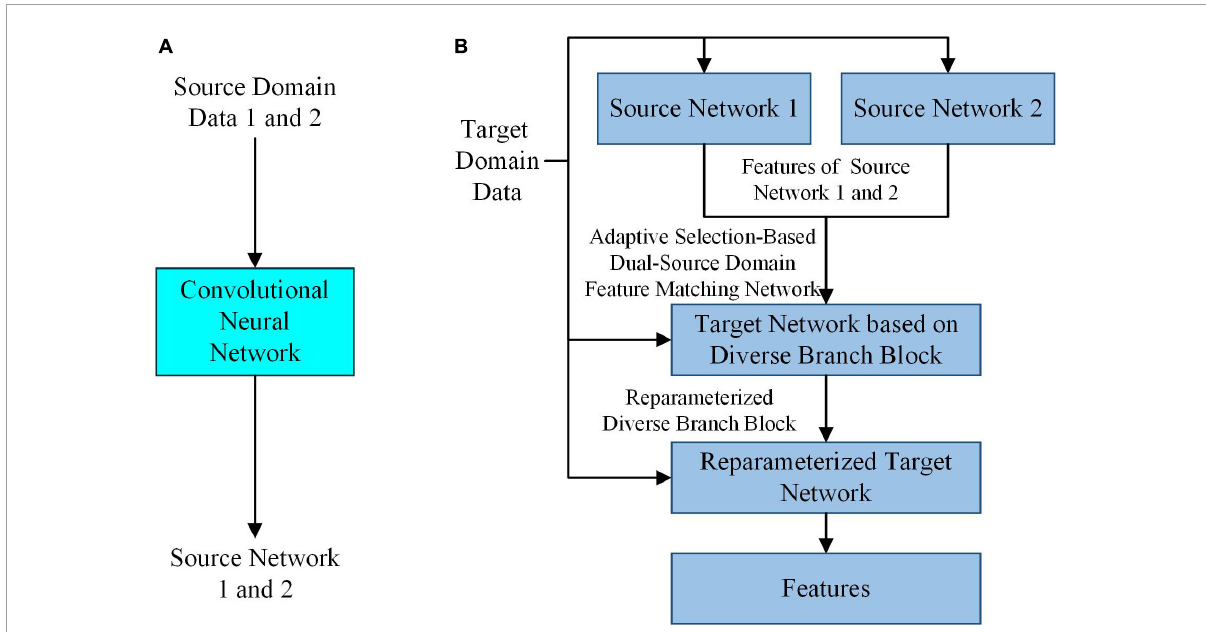
FIGURE2 The overall architecture of the feature extraction model. (A) Training of the source network. (B) Training of the target network based on diverse branch block and feature